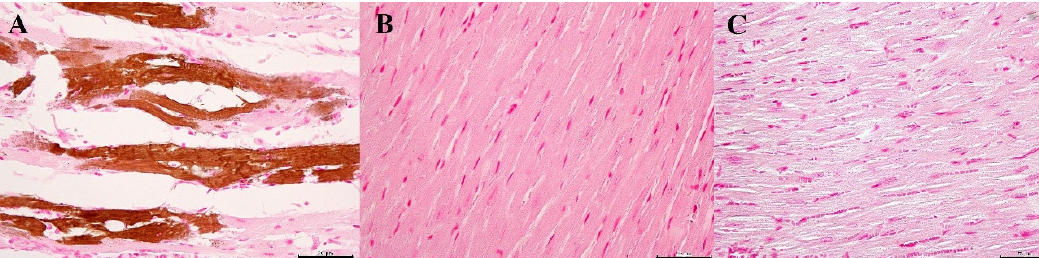
Figure 6. Histopathological changes in the cardiac muscles. ( A ) Vit D 3 -treated mice. Abundant granular mineralization (calcification) with degeneration and necrosis of the calcified fibers is noted in the cardiac muscles. von Kossa stain. Bar = 50 μ m. ( B ) Vit D 3 + SEF-treated mice. Calcification is not found. von Kossa stain. Bar = 50 μ m. ( C ) Untreated mice. von Kossa stain. Bar = 50 μ m.